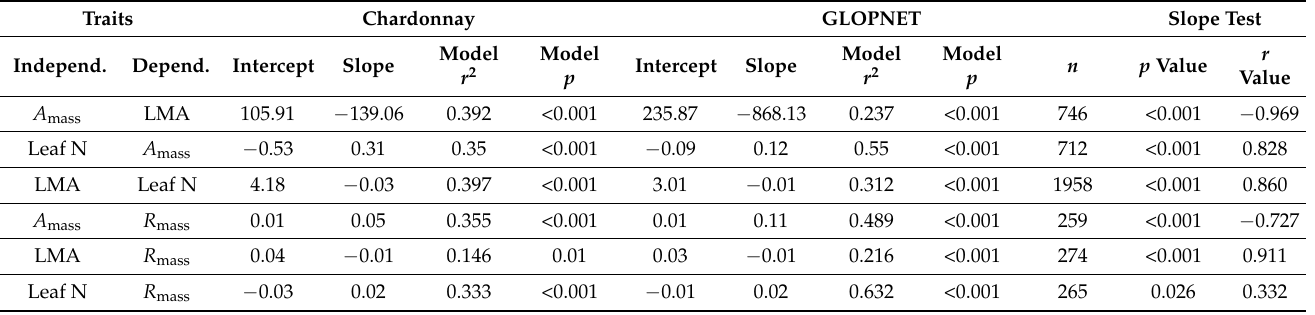
Table 2. Leaf Economics Spectrum (LES) trait relationships in ‘Chardonnay’ and wild plant species. Traits Chardonnay GLOPNET Slope